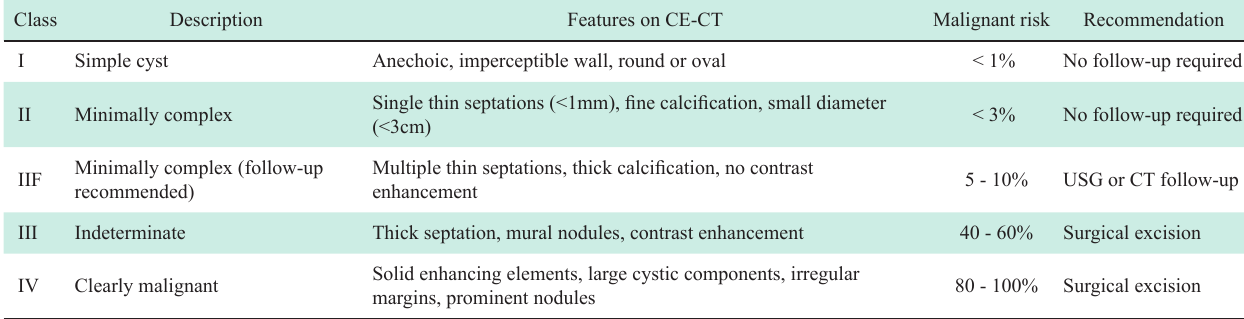
Table 1 Bosniak classification system